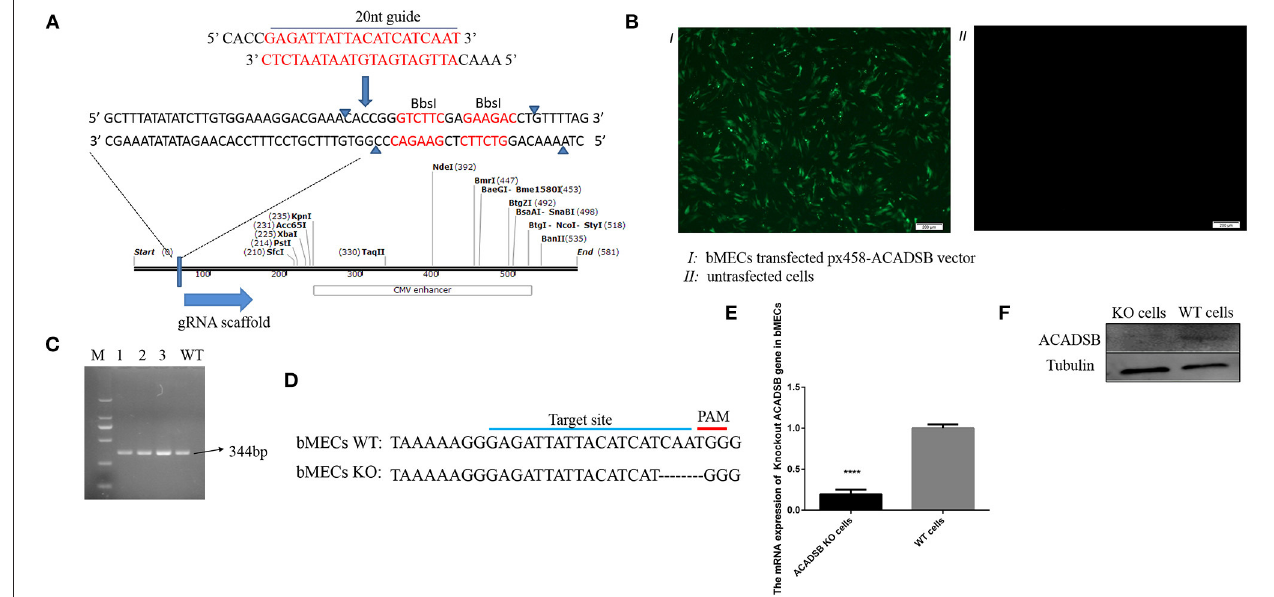
FIGURE 1 | Construction of ACADSB gene knockout vector and identification of mRNA and protein levels. (A) Construction of ACADSB gene recombinant knockout vector (PX458- ACADSB ). (B) PX458- ACADSB recombinant knockout vectors were transfected into bMECs. (C) The single positive cells were screened which can express green fluorescent protein by flowing cytometry and then were cultured for extracting the genome DNA to identify the edited cell line by PCR. (D) The sequence of the monoclonal PX458- ACADSB knockout cell line was compared with the wild cell line, the gRNA sequence was missing 4 bases near the PAM site, causing a frameshift mutation. (E) ACADSB relative mRNA expression levels in ACADSB − / − bMECs and wild type bMECs line. (F) ACADSB relative protein expression levels in ACADSB − / − bMECs and wild type bMECs